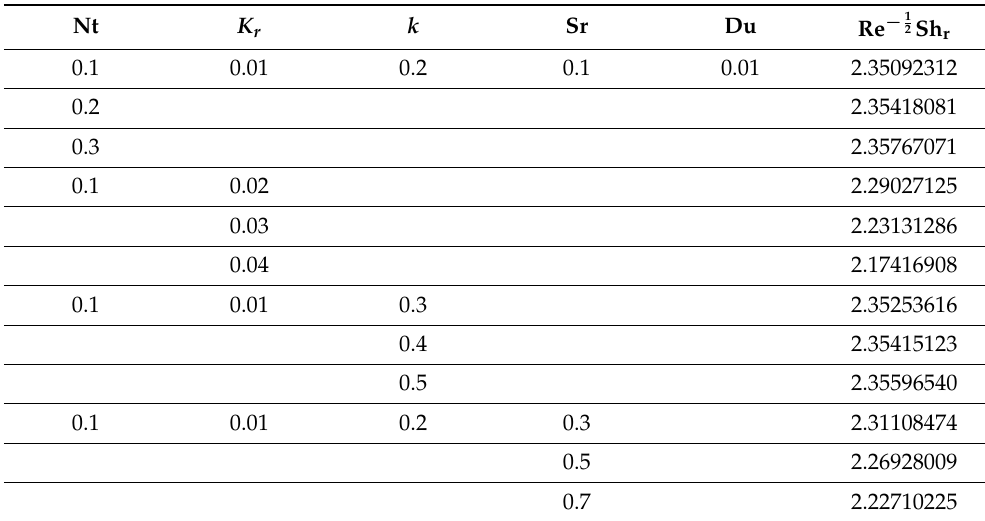
Table 2. Variation of Re − 1 2 Sh r on Nt, K r , k , Sr, and Du,